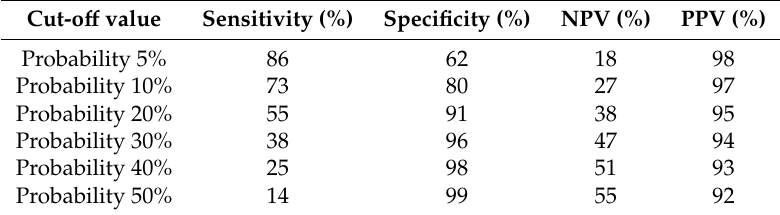
Table 3. Sensitivity, specificity, NPV and PPV for the developed prediction model, operationalized in the calculator, for an abnormal ASQ total score at age 4 at several cut-o ff values.